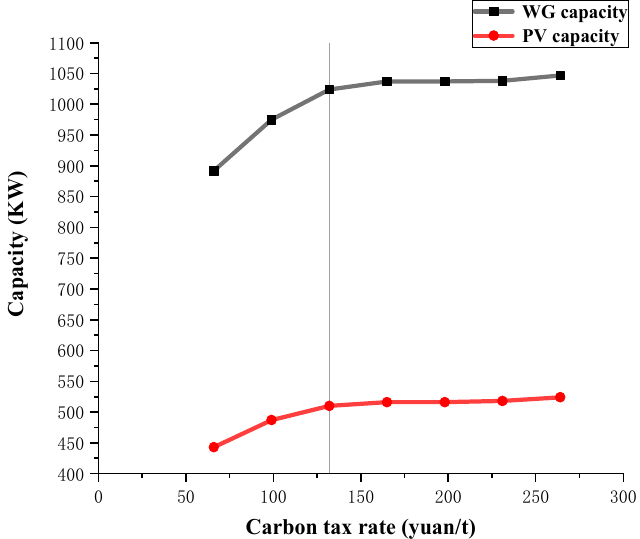
Figure 13. The WG-PV capacity changes under different carbon emission tax rates.